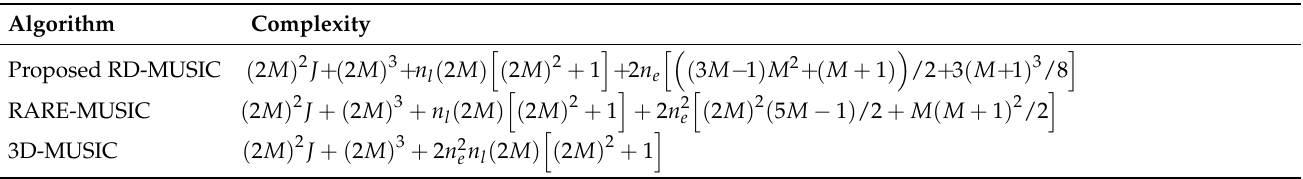
Table 2. Computational complexity of algorithms.